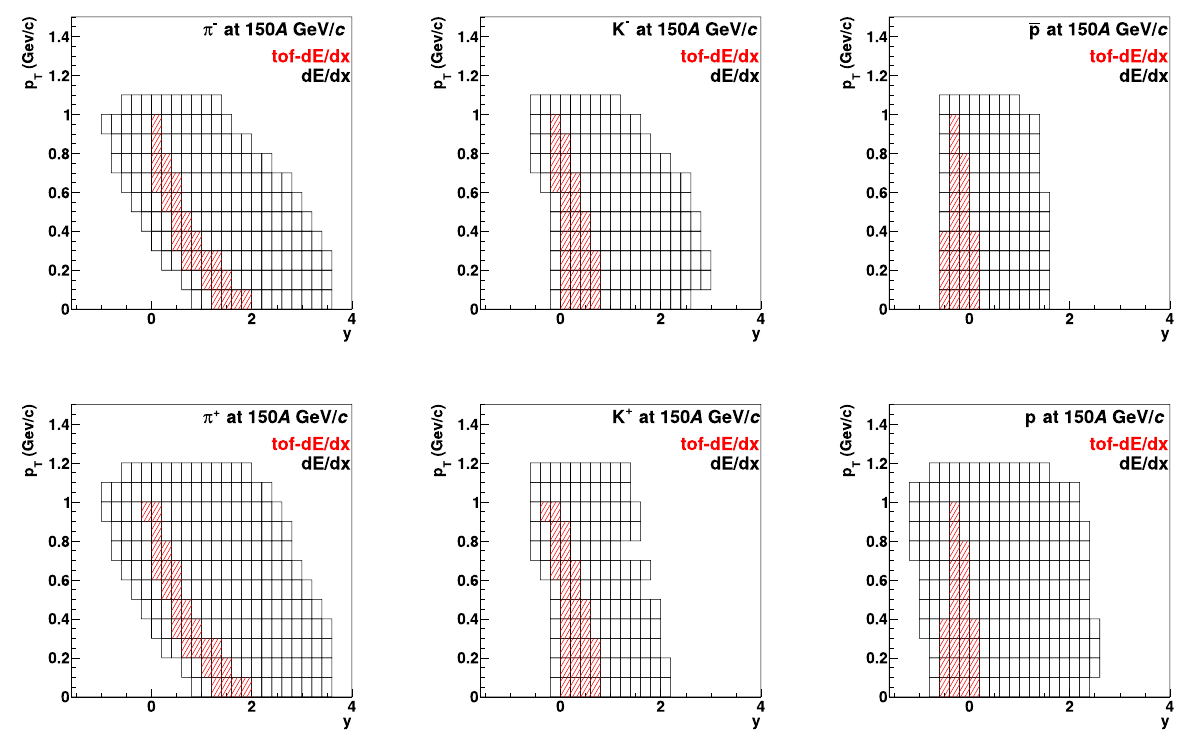
Fig. 6 Acceptanceofthe tof -d E / d x andd E / d x methods for identificationof pions, kaons andprotons inthe 20% most central Be+Beinteractions at 150 A GeV / c